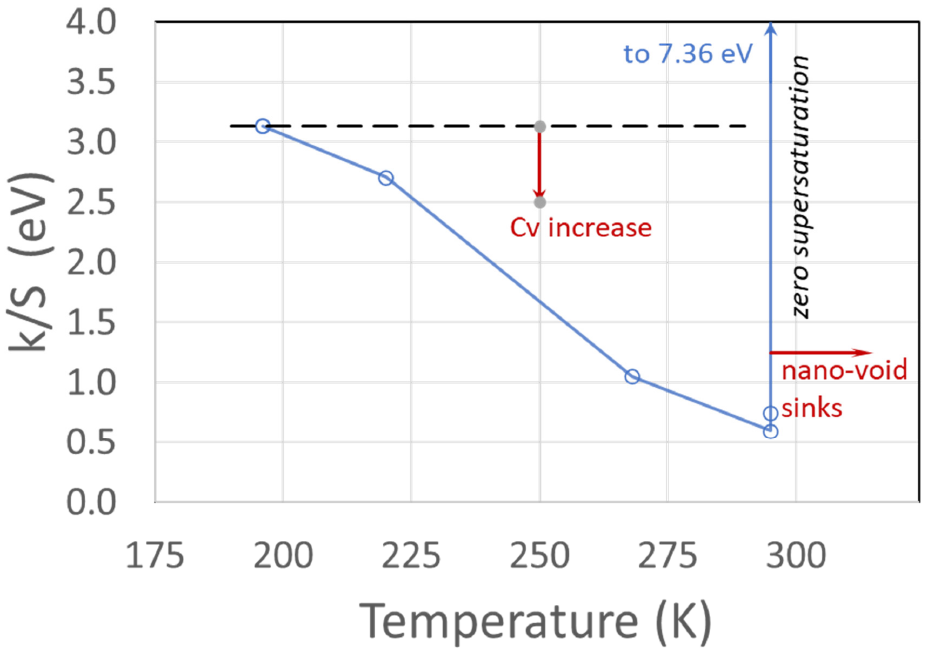
Figure 10. Activation work (k/ S ) versus temperature for sealed GB specimens determined at the largest S up prior to reduction due to vacancy sink formation.